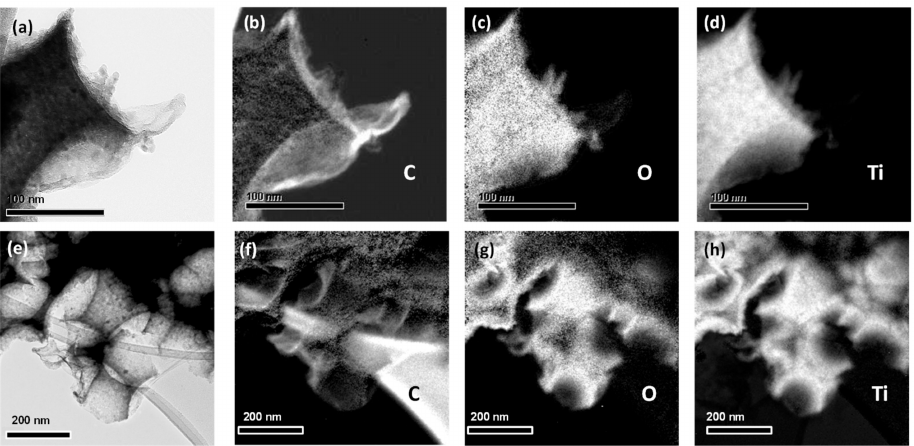
Figure 2. Bright-field TEM image and the corresponding C, O, and Ti energy-filtered TEM (EF-TEM) elemental maps of ( a )–( d ) GOnano-PC and ( e )–( h ) rGOnano(200)-PC.